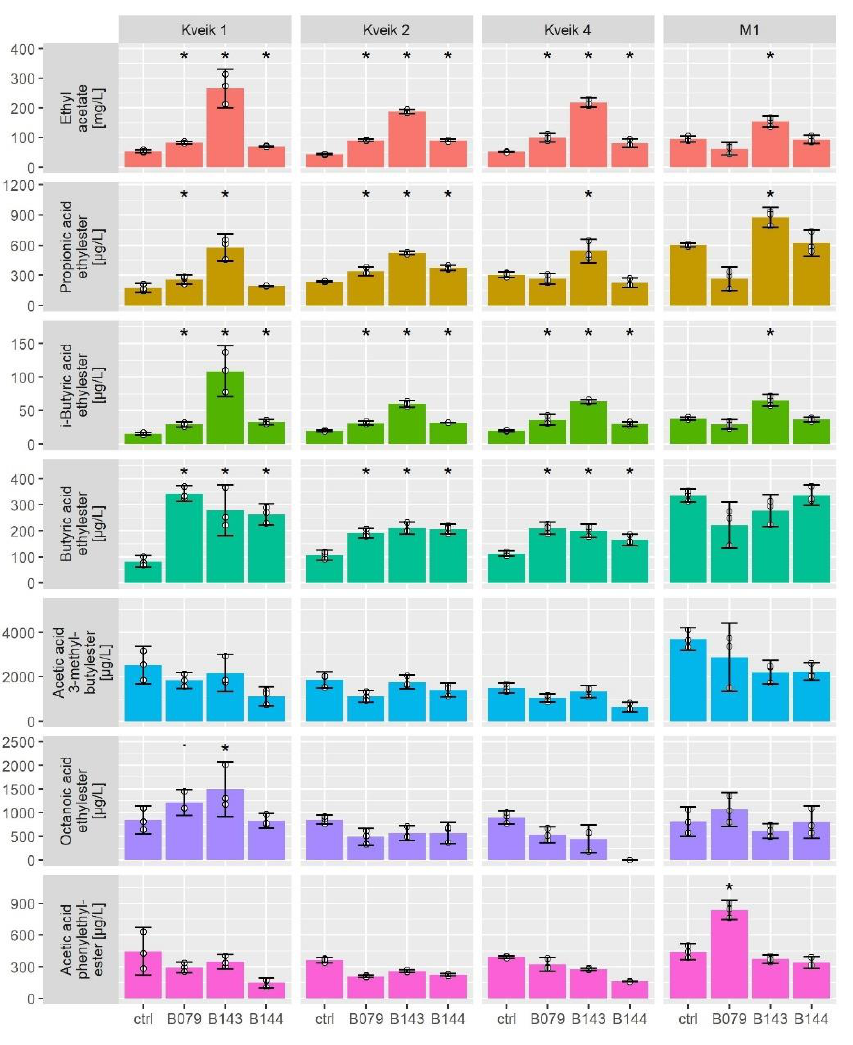
Figure 4. Amounts of selected volatile aroma compounds of Kveiks and M1 single and co- fermentations. Bar height is the mean of 3 replicate fermentations. Error bars show 80% quantile interval around the mean; white points are the measured values. Asterisk: difference to control was significant ≤0.05; dot: difference to control was significant ≤0.10. B079— H. uvarum ; B143 — P.